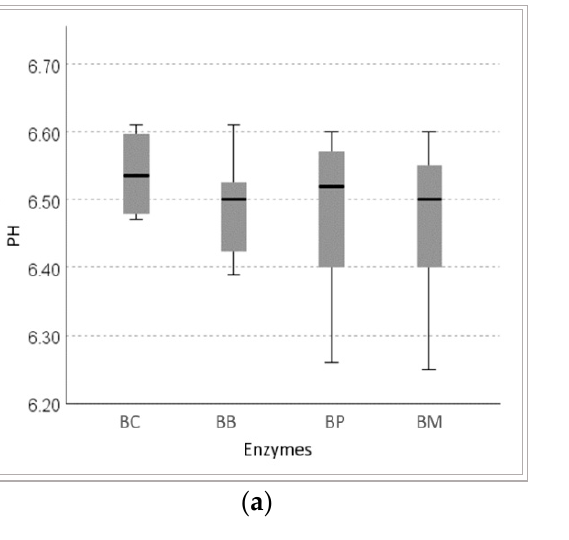
Figure 2. Changes in pH of all tested bran samples: ( a ) after 2 h; ( b ) and 4 h of hydrolysis with different enzymes (BC, control bran sample; BB, bran treated with bromelain; BP, bran treated with papain; BM, bran treated with a combination of bromelain and papain; the “°” marks indicate the median of pH for the bran control samples).